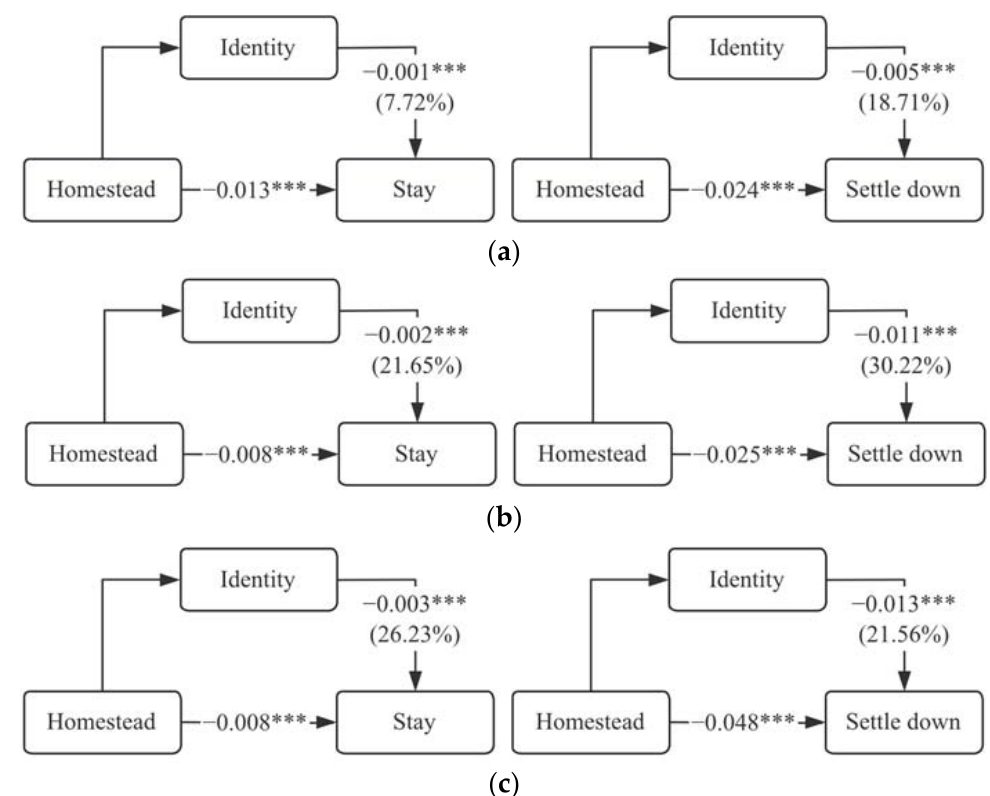
Figure 4. Mediating relationship of migration distance. ( a ) Within the city; ( b ) within the province but outside the city; ( c ) outside the province. *** p < 0.01.